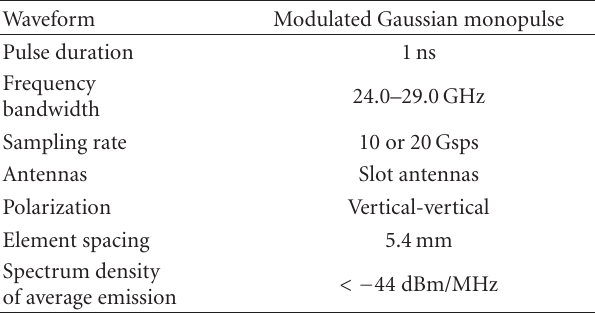
Table 1: Specification of